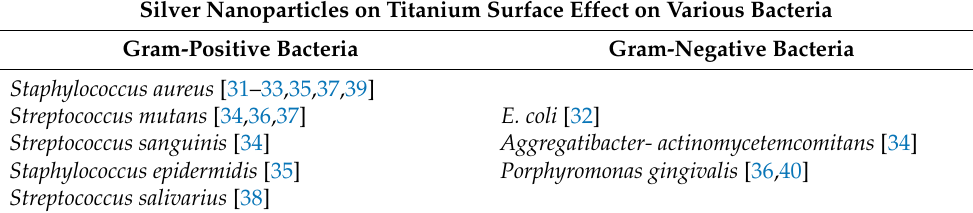
Table 2. Polymeric surface coating with embedded silver nanoparticles onto a titanium surface has successfully reduced the Gram-positive and Gram-negative